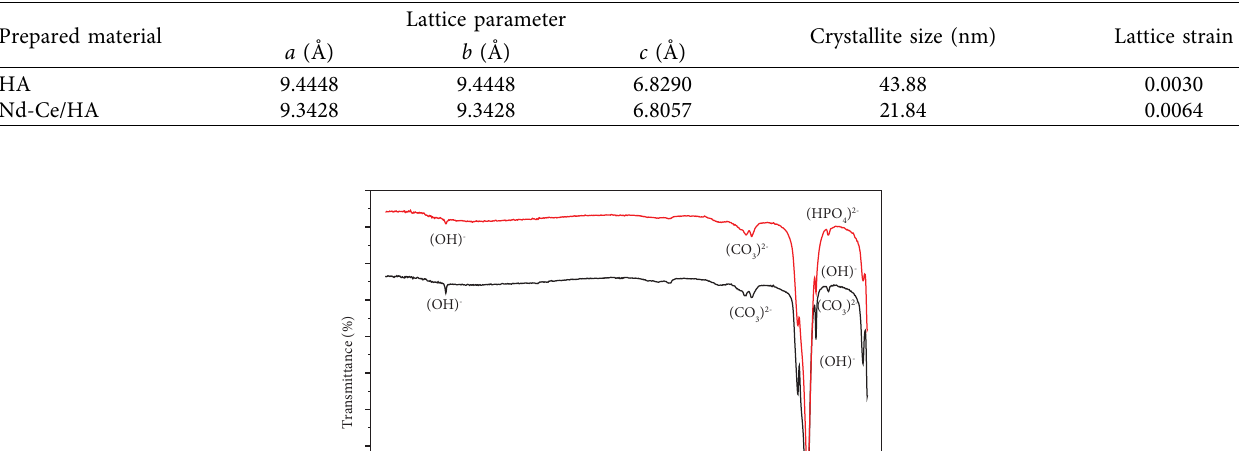
Table 2: Important factors calculated from the extracted data of the XRD test.